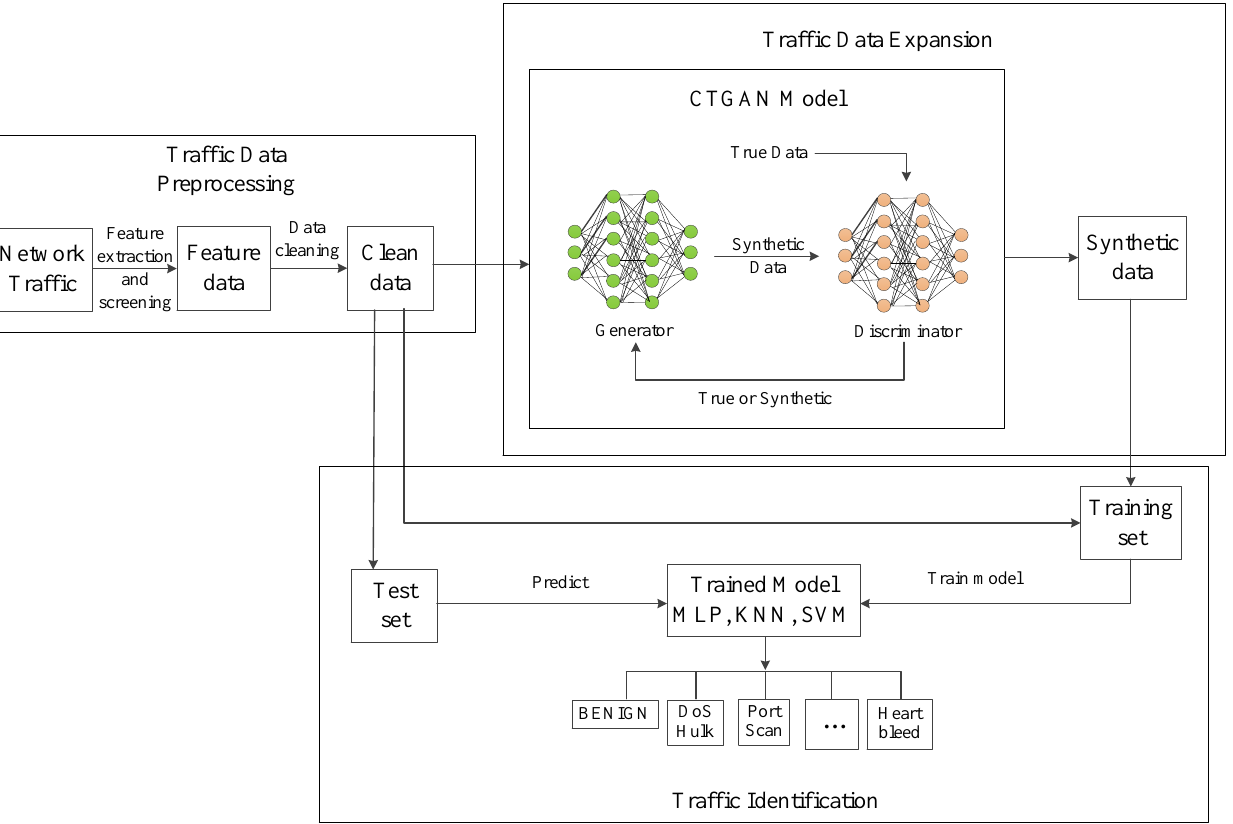
Figure 2. CTTGAN scheme flow